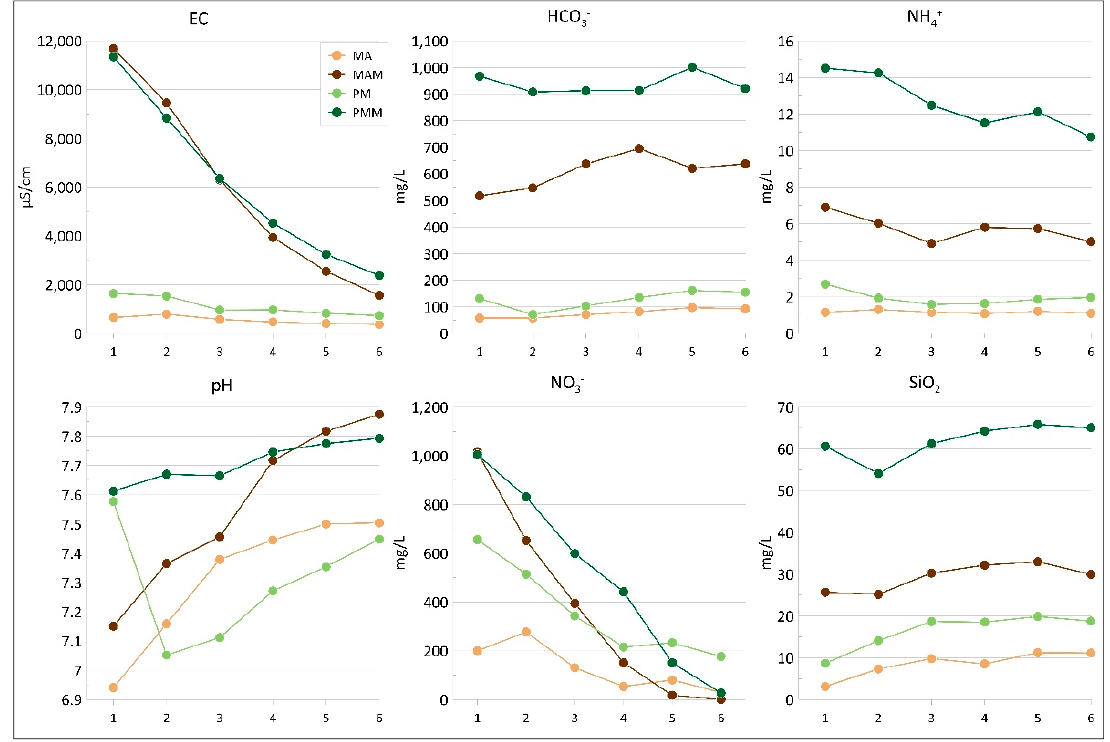
Figure 7. Temporal variations in physico-chemical parameters of the water percolating in the four columns. Six consecutive samples were collected every 20 min after the first leached water (approximately one hour after the start of the test).